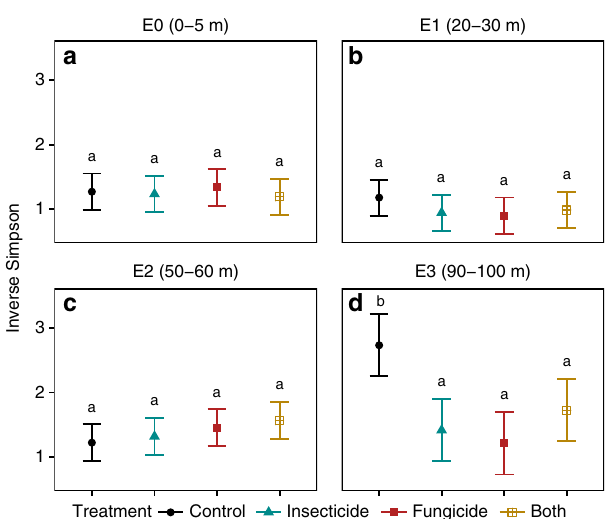
Fig. 3 Change in seedling diversity with pesticide treatments at increasing distances from the forest edge. Diversity was estimated for: a 0 – 5 m (E0), b 20 – 30 m (E1), c 50 – 60 m (E2), and d E3 (90 – 100 m) from the forest edge. Points represent mean observed diversity of new seedlings recruiting into 1 m 2 plots where the different pesticide treatments were applied ( N = 146 per treatment). Error bars show 95% con fi dence intervals. Statistical differences were estimated using linear mixed-effects models, letters denote signi fi cant pairwise differences among